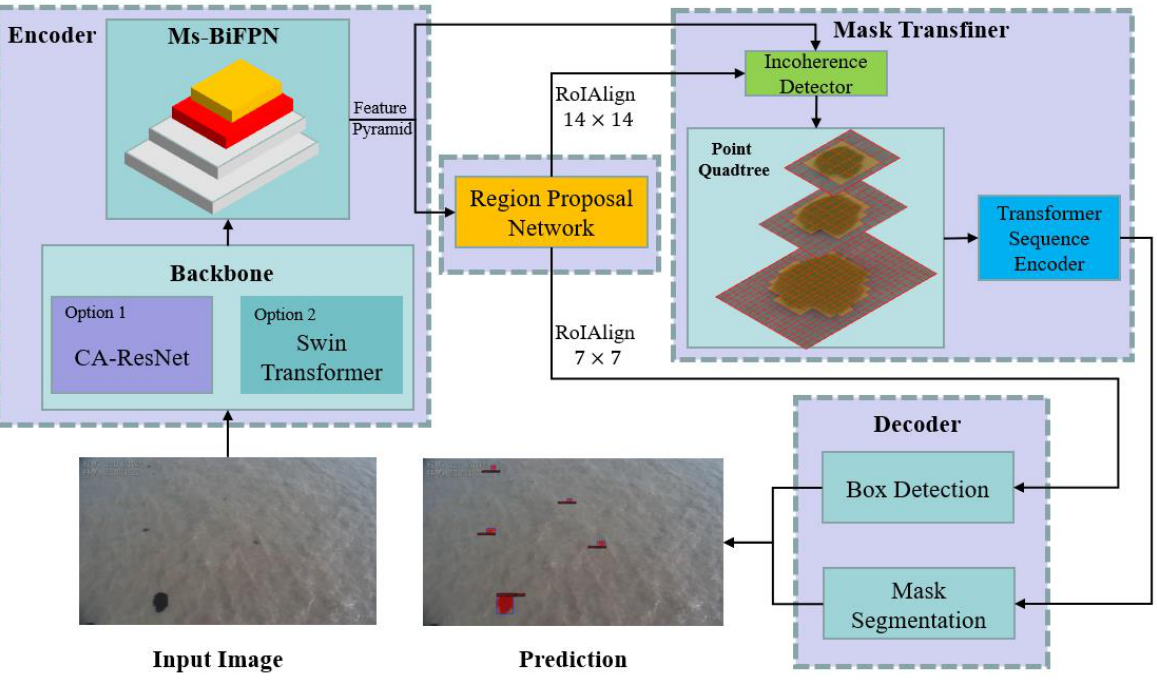
Figure 1. The architecture of AlgaeFiner.